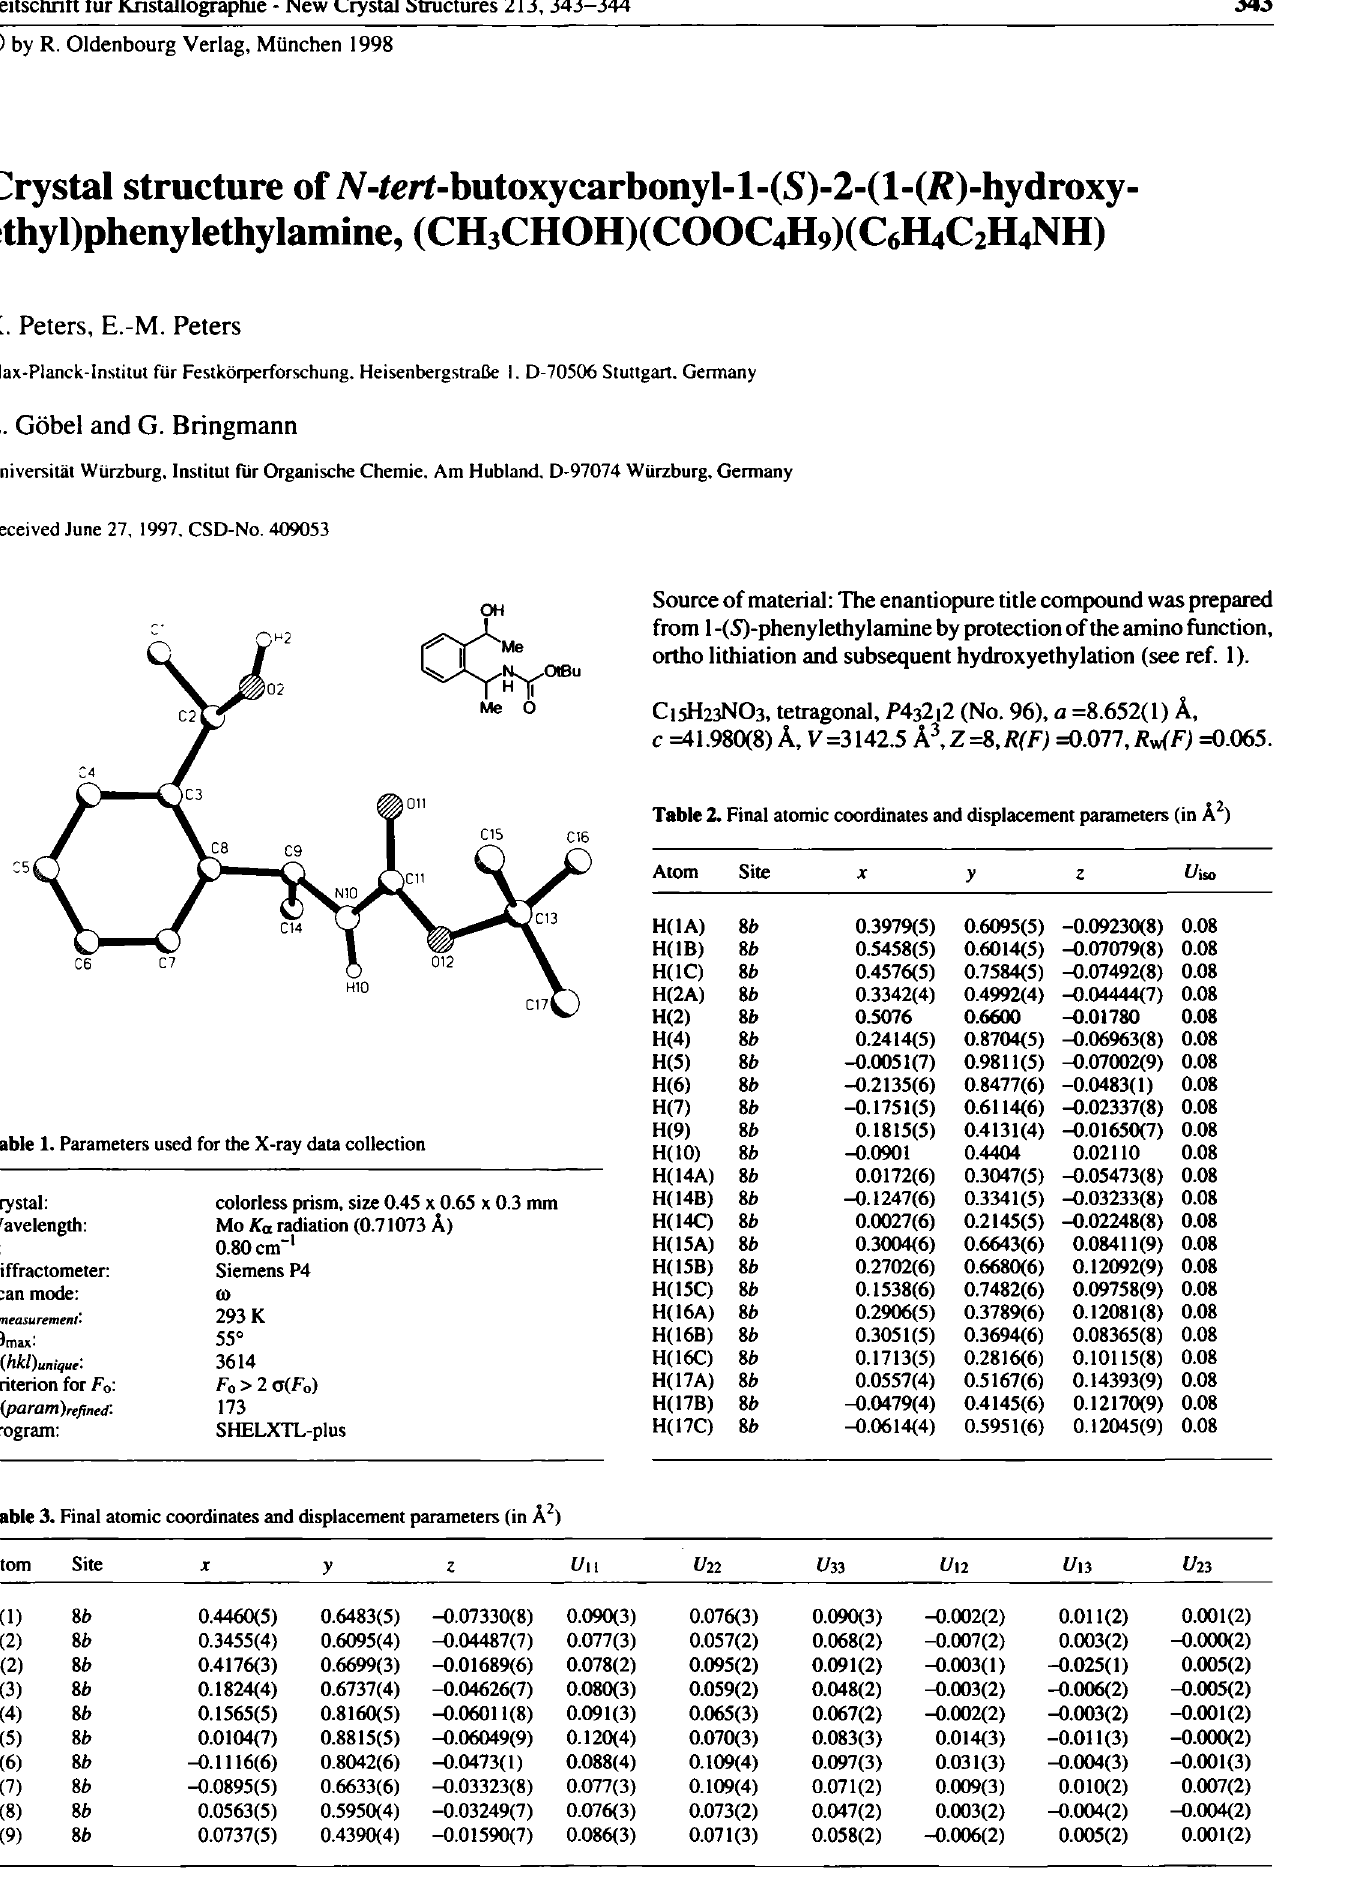
Table 3. Final atomic coordinates and displacement parameters (in Л^)